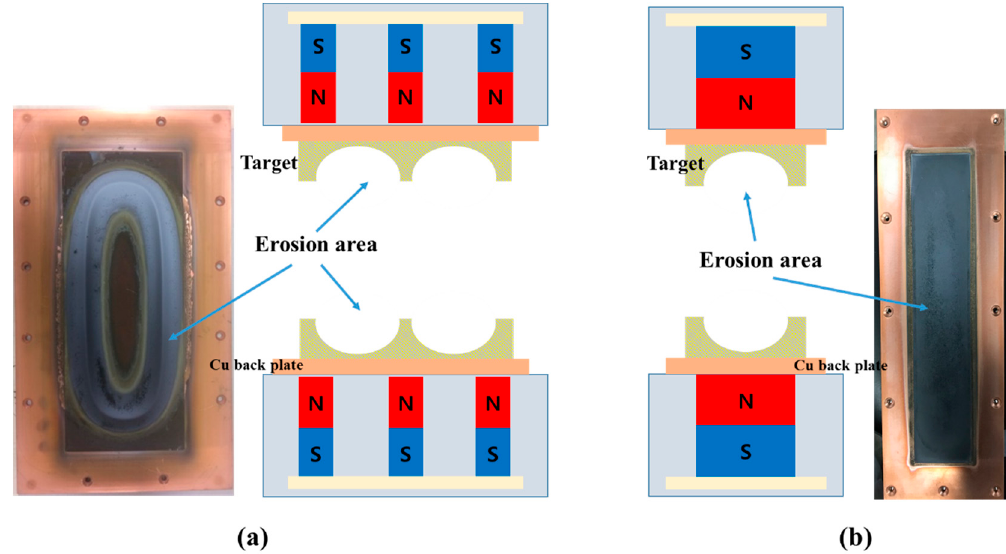
Figure 4. Photos of targets after sputtering and cross-sectional profiles of sputter target erosion. ( a ) Open-type FTS and ( b ) closed-type FTS.